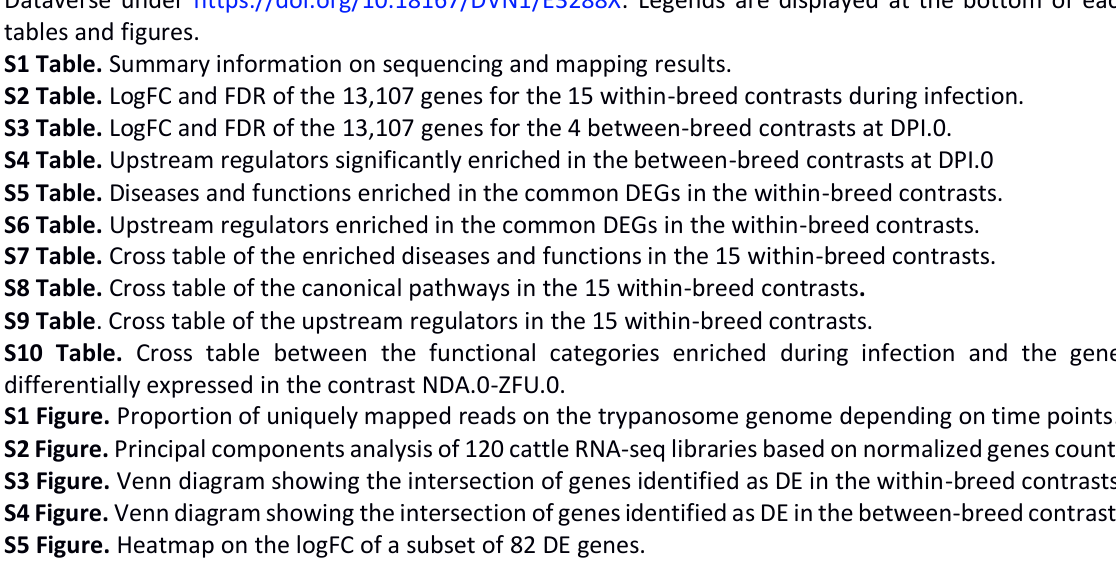
S1 Table. Summary information on sequencing and mapping results. S2 Table. LogFC and FDR of the 13,107 genes for the 15 within-breed contrasts during infection. S3 Table. LogFC and FDR of the 13,107 genes for the 4 between-breed contrasts at DPI.0. S4 Table. Upstream regulators significantly enriched in the between-breed contrasts at DPI.0 S5 Table. Diseases and functions enriched in the common DEGs in the within-breed contrasts. S6 Table. Upstream regulators enriched in the common DEGs in the within-breed contrasts. S7 Table. Cross table of the enriched diseases and functions in the 15 within-breed contrasts. S8 Table. Cross table of the canonical pathways in the 15 within-breed contrasts . S9 Table . Cross table of the upstream regulators in the 15 within-breed contrasts. S10 Table. Cross table between the functional categories enriched during infection and the genes differentially expressed in the contrast NDA.0-ZFU.0. S1 Figure. Proportion of uniquely mapped reads on the trypanosome genome depending on time points. S2 Figure. Principal components analysis of 120 cattle RNA-seq libraries based on normalized genes counts. S3 Figure. Venn diagram showing the intersection of genes identified as DE in the within-breed contrasts. S4 Figure. Venn diagram showing the intersection of genes identified as DE in the between-breed contrasts. S5 Figure. Heatmap on the logFC of a subset of 82 DE